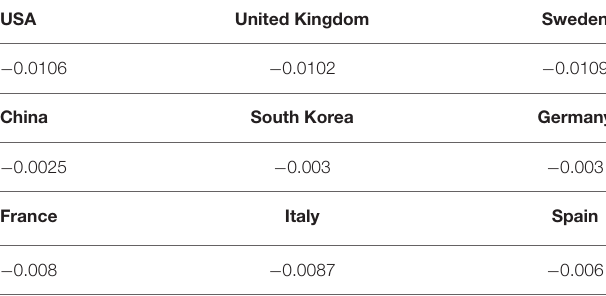
TABLE 1 | Slopes of the linear final trends of the KM